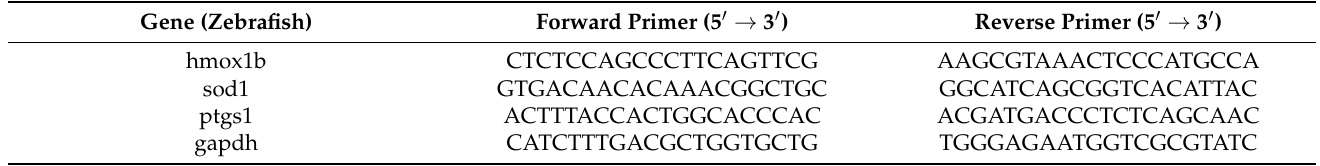
Table 2. Primer sequences used to assess gene expression in zebrafish brain lysate. Gene